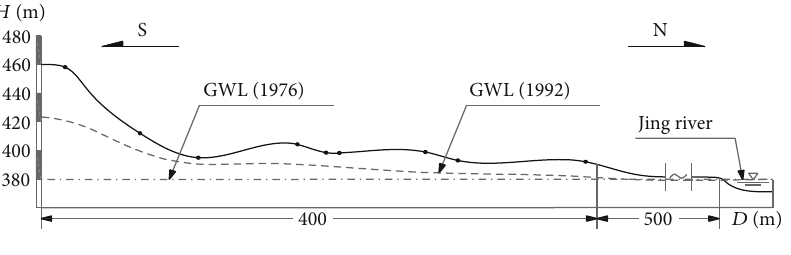
Figure 8: Sketch of the cross-section of D-D ′ . Table 2: Physical properties of soil for high loess slope.